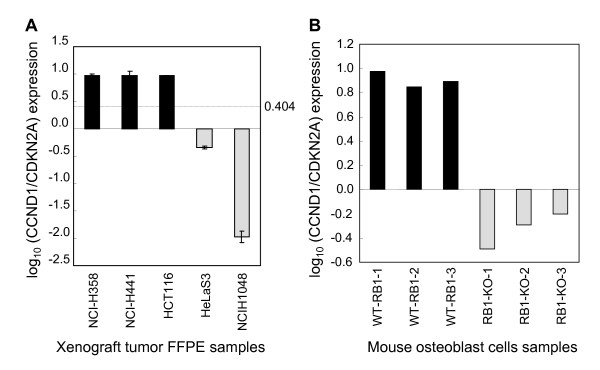
CCND1/CDKN2A expression predicts RB1 status in animal tumor models. (A) mRNAs from five xenograft tumors were purified from FFPET and analyzed with quantitative RT-PCR for CCND1 and CDKN2A. NCI-H358, NCI-H441, and HCT116 cell lines are known to be RB1-positve. HeLaS3 and H1048 cell lines are known to be RB1-negative. The cut-off value of log10 (CCND1/CDKN2A) ratio to classify RB1 status is shown: 0.404. (B) CCND1/CDKN2A expression was analyzed in osteoblast cells derived from RB1 wild-type and RB1 knockout mice using publicly available microarray expression data (GEO: GSE19299).